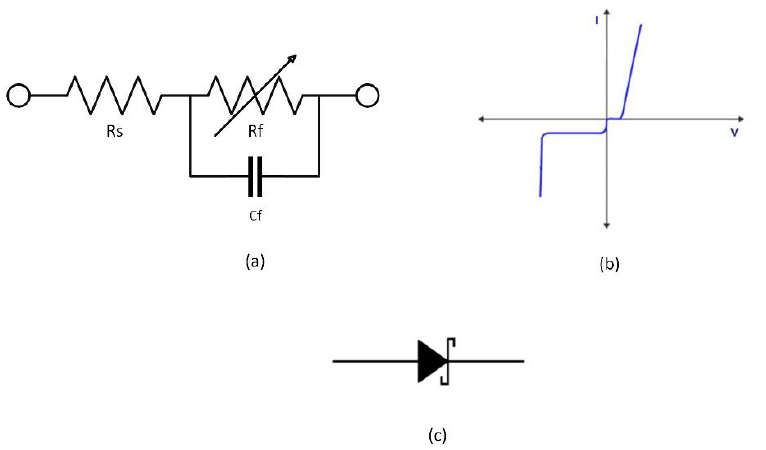
Figure 7. The characteristics of a diode ( a ) electronic equivalent circuit ( b ) I-V characteristic of Schottky diode ( c ) symbol of Schottky diode.